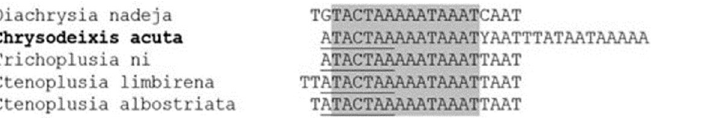
Fig 3. Alignment of the intergenic spacer region between trnS2 (UCN) and nad1 of several lepidopteran insects of Plusiinae subfamily. ATACTAA motif is underlined and the TACTAAAAATAAAT is shaded.